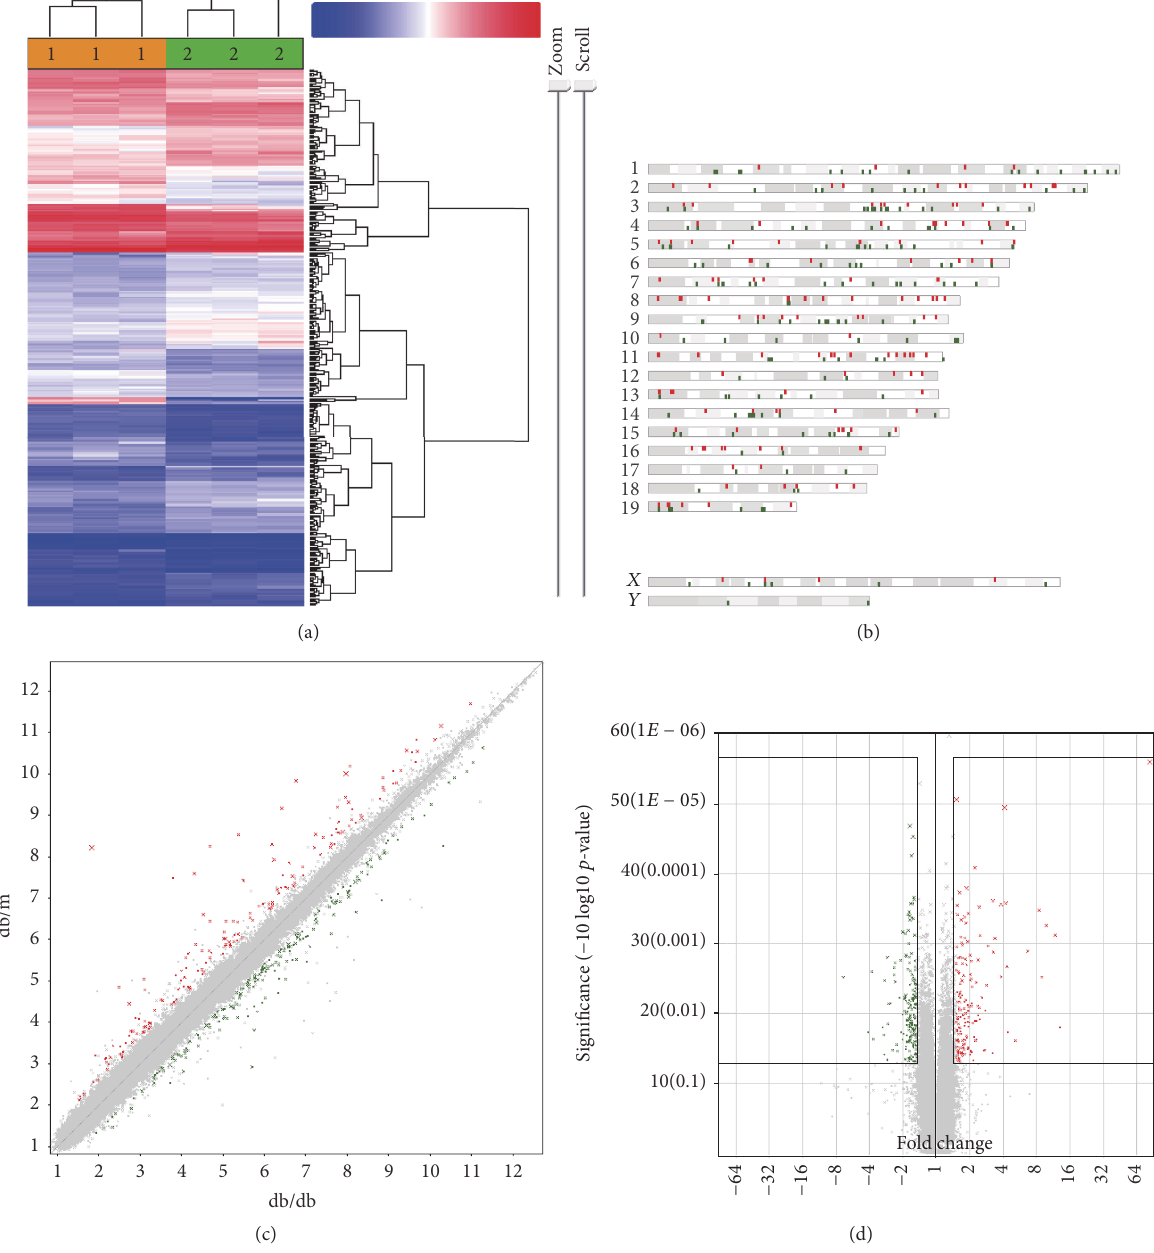
Figure 2: Identification of DEGs in the transcriptional profile from db/db and db/m mice at 22 w old. (a) Signal values are plotted and clustered in a heat map to determine overt differences in the signal between the 2 samples by TAC. (b) Chromosome distribution analysis shows where induced or repressed genes in db/db mice are located in the mouse genome. (c) Fold change calculated using the TAC software is exhibited as a scatter plot. Genes upregulated in db/db mice are shown in red, whereas downregulated genes are shown in green. (d) A fold change for each gene exceeding 1.5-fold change is plotted against significance as calculated by one-way ANOVA in a volcano plot. DEGs within the black boxes are considered for further ontology and pathway